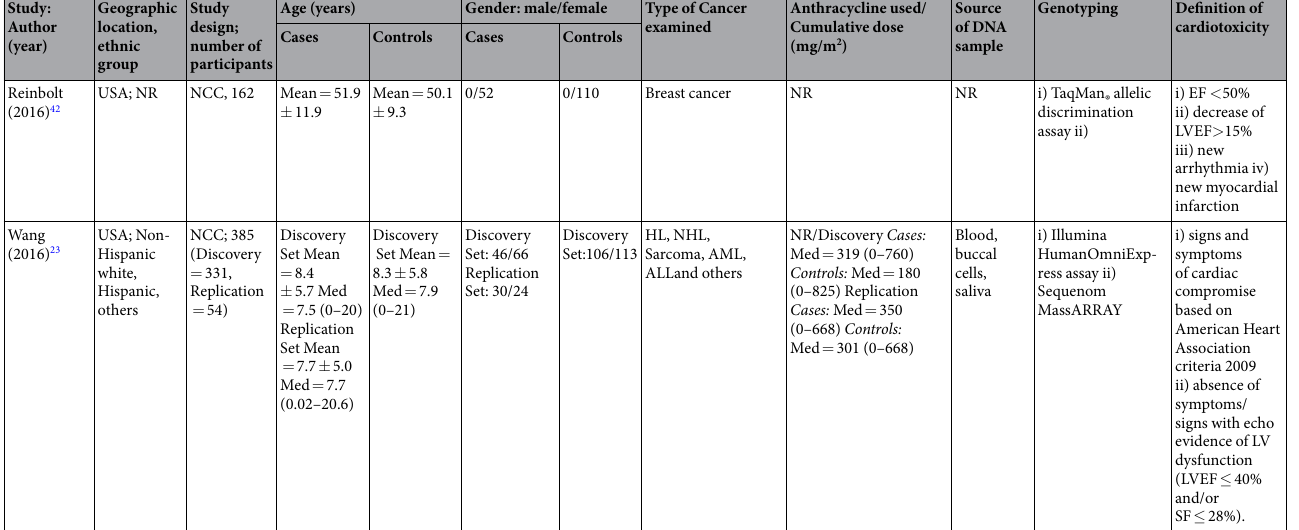
Table 1. Descriptions of included studies. ALL, acute lymphoblastic leukaemia; AML, acute myeloid leukaemia, BM, bone marrow; CC, case-control; EF, ejection fraction; FFPE, Formalin-fixed, paraffin-embedded;